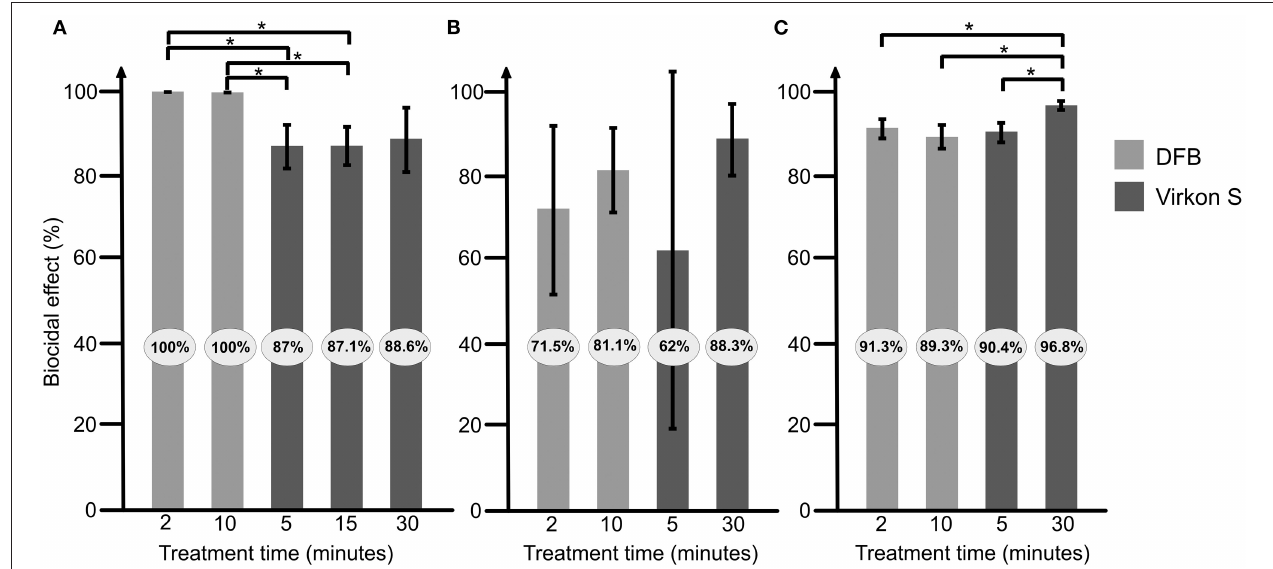
FIGURE 2 | Efficacy of the 2 disinfectants “Disinfection for beekeeping” (DFB) and Virkon S on Paenibacillus larvae spores in suspension (A) , on wood (B) , and on Styrofoam (C) . Light gray bars shows results for DFB and darker gray Virkon S. The result is presented as an average from at least 3 repeats, with error bars indicating standard deviation. Significant differences are indicated. * P <